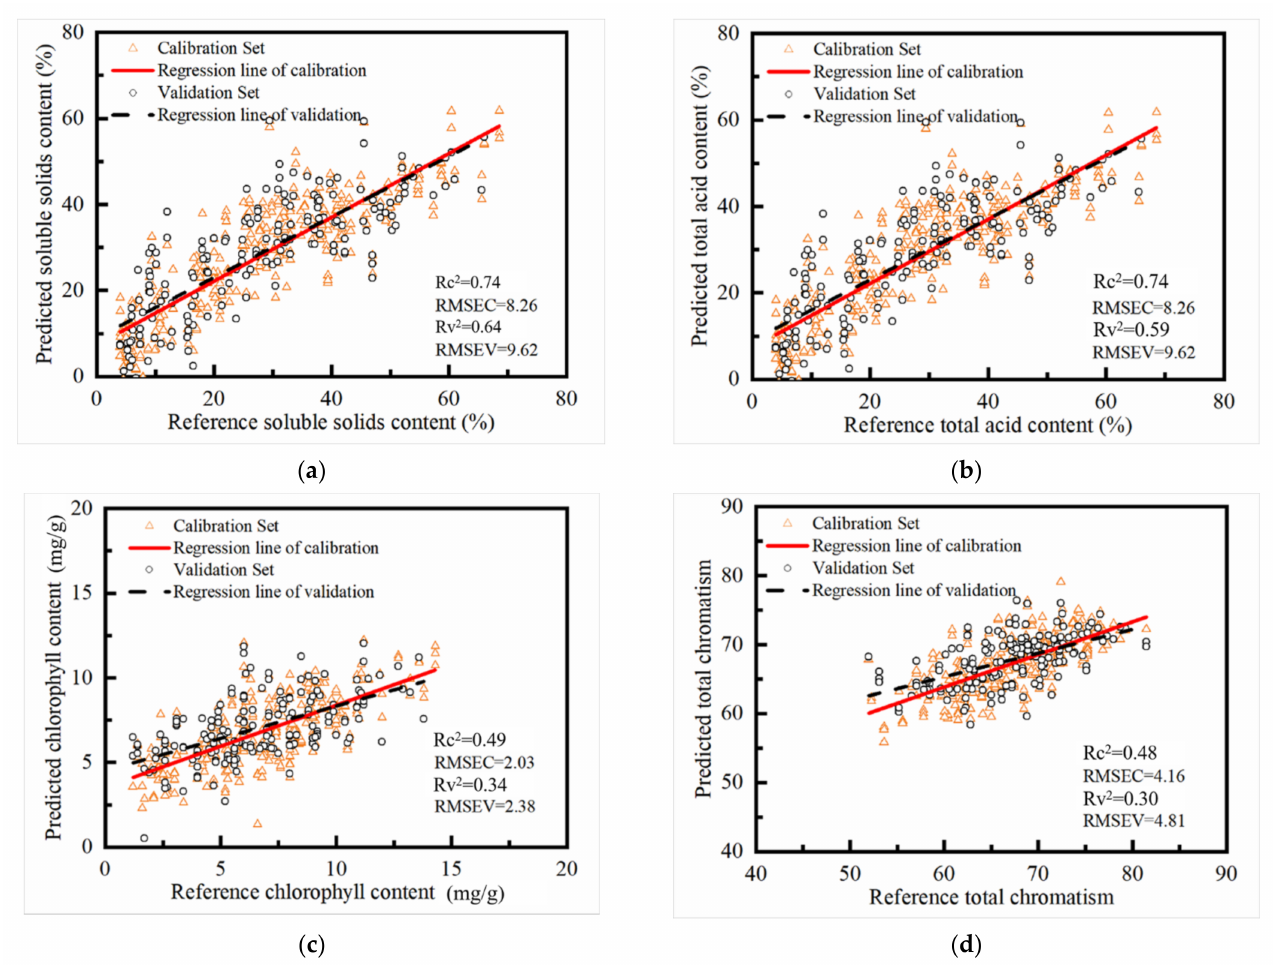
Figure 7. Scatter plots of the actual and predicted values for ( a ) SSC; ( b ) TA; ( c ) chlorophyll and ( d ) ∆ E*. The triangular data points and solid regression lines were measured for calibration sets; the triangular data points and long dashed regression lines were measured for validation sets.